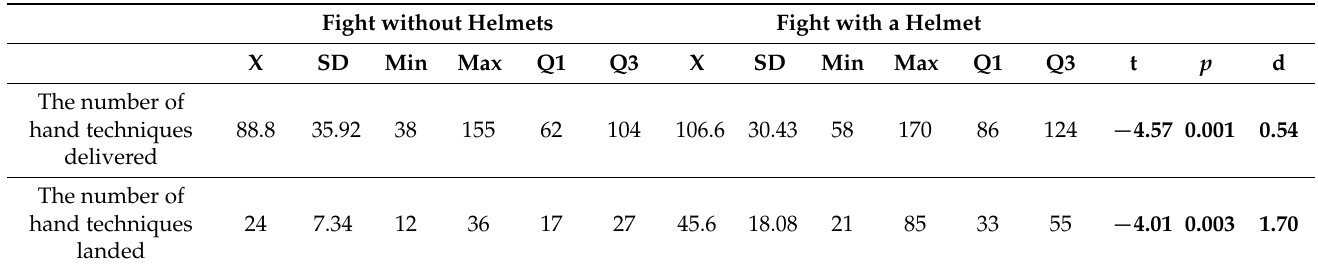
Table 3. Descriptive and comparative statistics of fights with and without a helmet in relation to hand techniques.